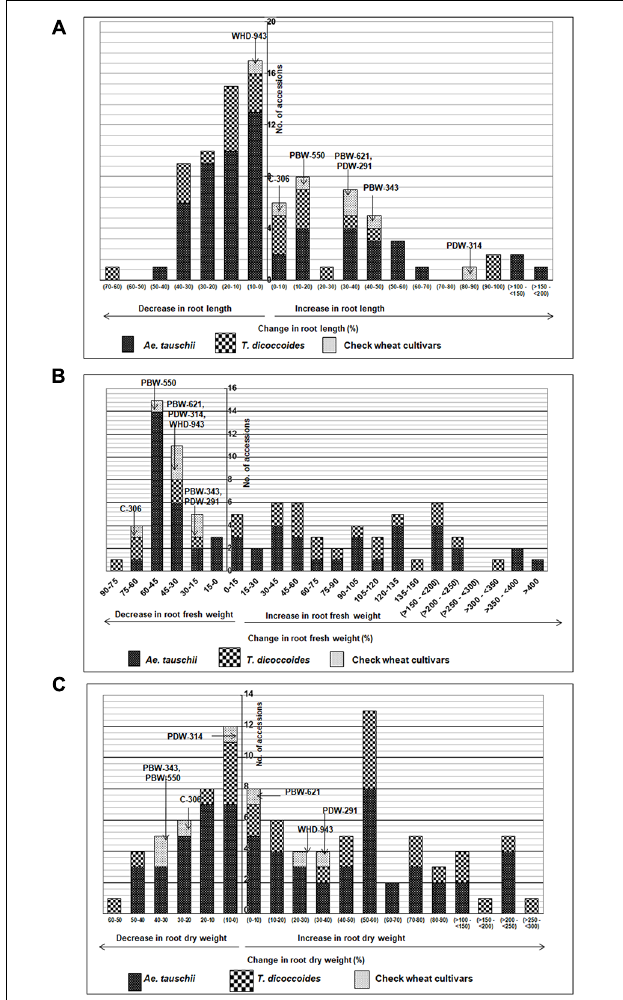
FIGURE 3 | Distribution of accessions of Ae. tauschii , T. dicoccoides and check wheat cultivars with regard to change in (A) root length, (B) root fresh weight, and (C) root dry weight under well watered and water stress